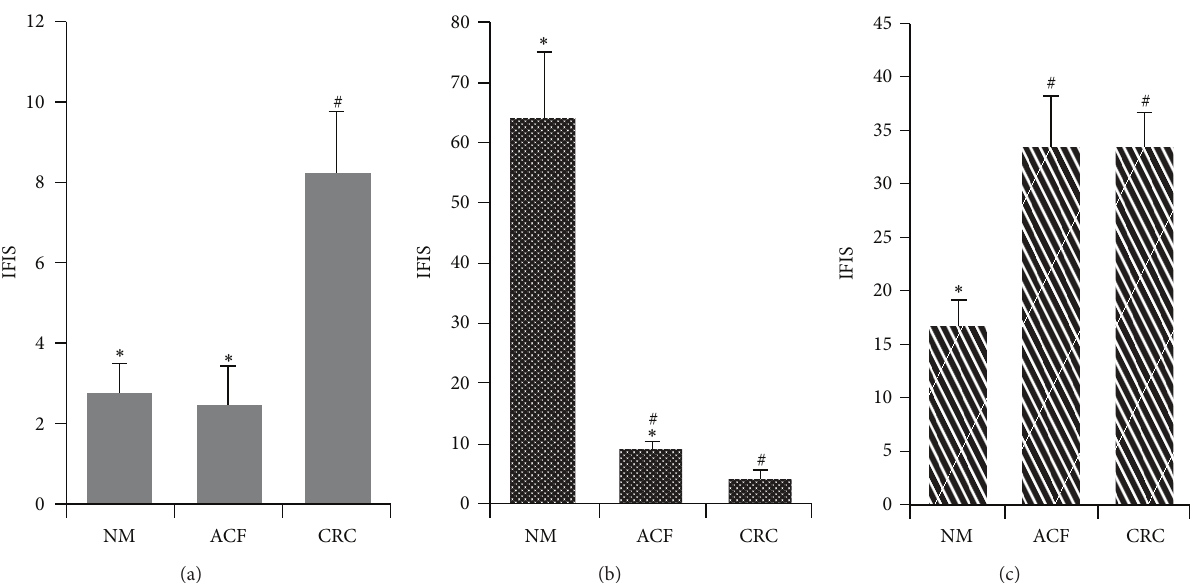
Figure 1: CD2, CD56, and PLZF fluorescence levels along colorectal carcinogenesis. Fluorescence levels of CD2 (a), CD56 (b), and PLZF (c) immunostaining in normal colorectal mucosa (NM), aberrant crypt foci (ACF), and colorectal carcinoma (CRC), expressed by immunofluorescence intensity score (IFIS). # 𝑃 < 0.05 versus NM; ∗ 𝑃 < 0.05 versus CRC.